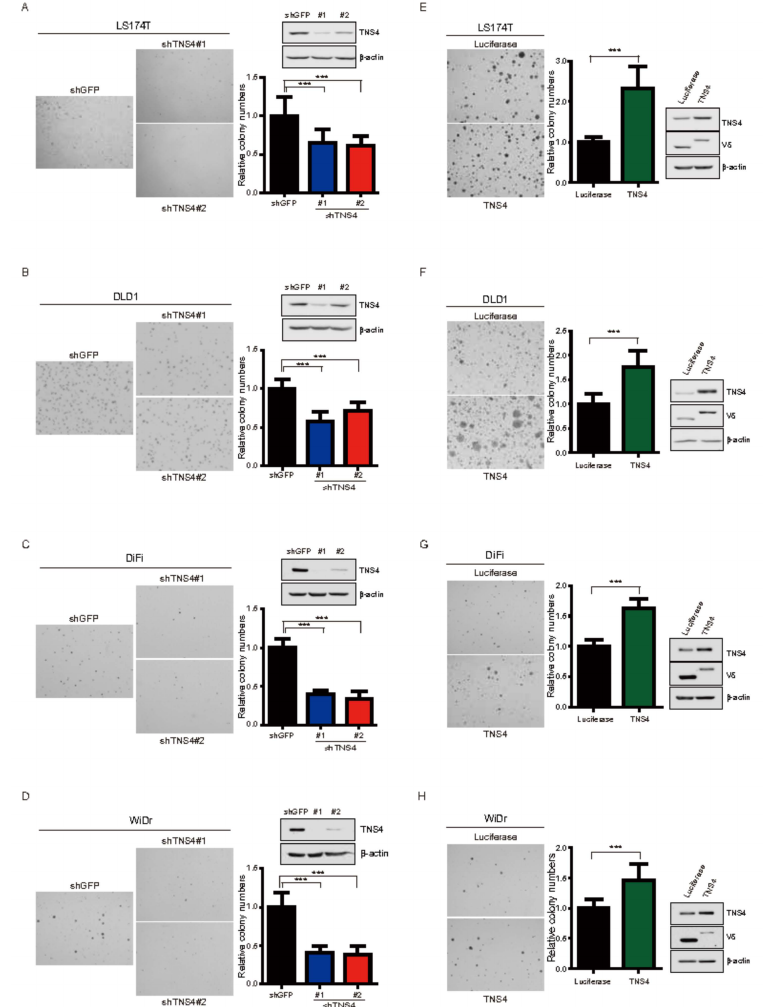
Figure3. TNS4expressionisassociatedwiththeoncogenicpotentialofcoloncancercells. ( A – D )LS174T( A ), DLD1 ( B ), DiFi ( C ) and WiDr ( D ) cells stably expressing either shTNS4 or shGFP were used for